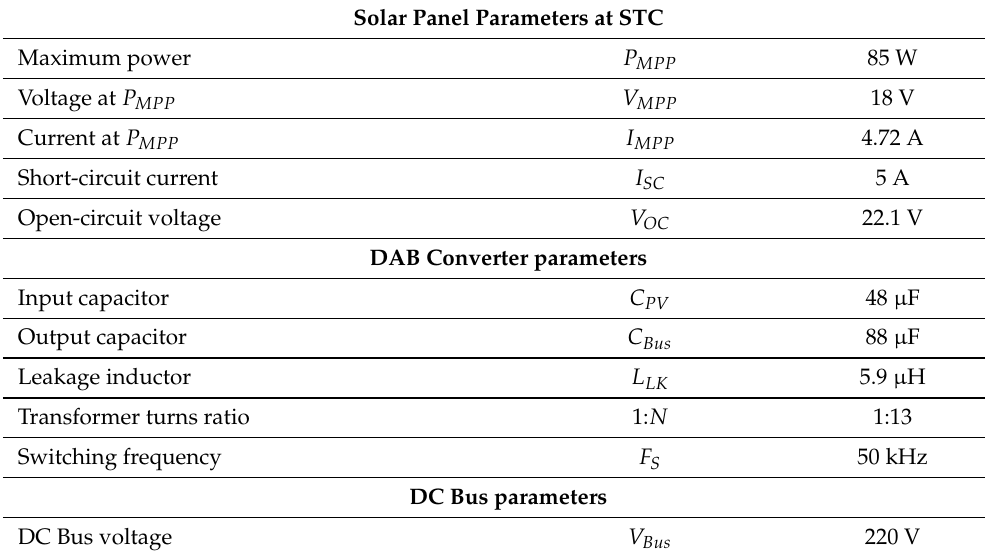
Table 2. PV panel and DAB converter